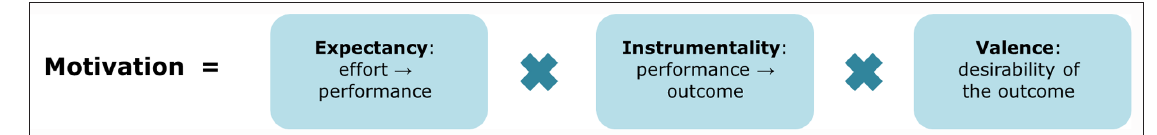
Figure 1: Vroom’s Expectancy Theory, based on Vroom (1964). Motivation can be described as being influenced by a combination of three components: Expectancy, instrumentality, and